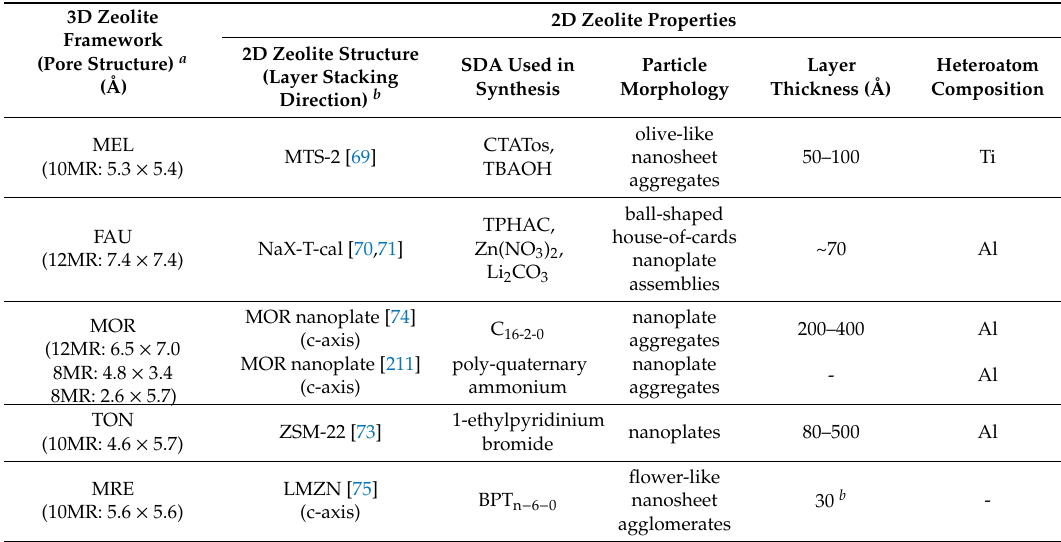
Table 9. Structural and compositional properties of other types of 2D zeolite